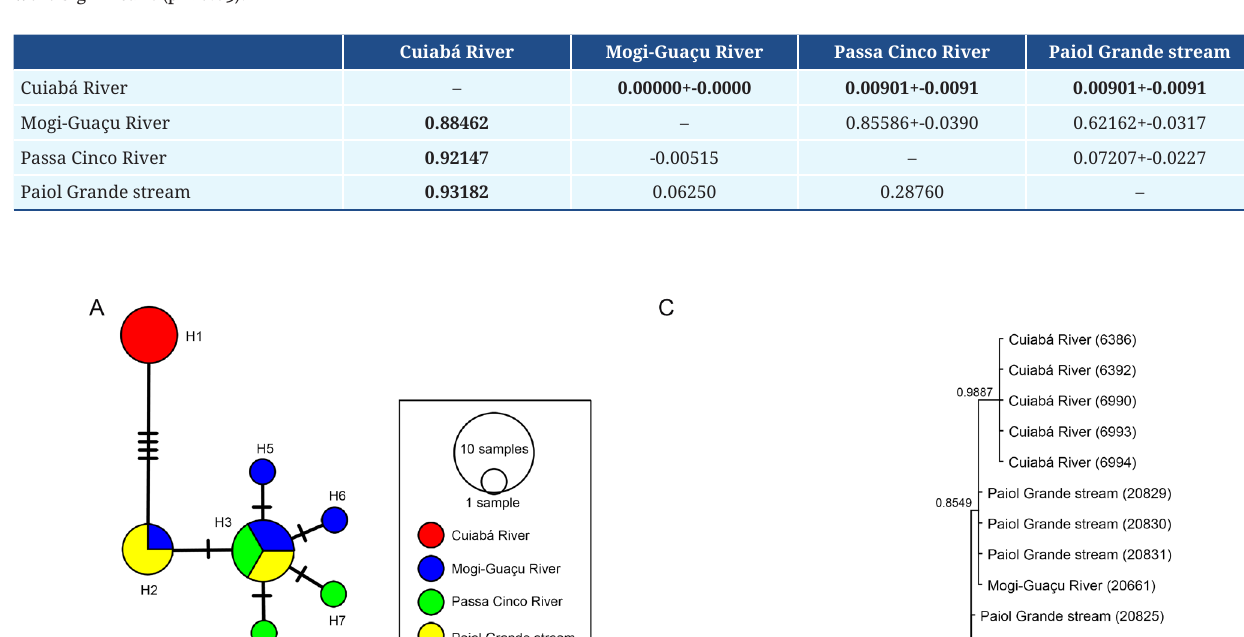
TABLE 4 | Population pairwise FSTs values for the populations of Parodon nasus (lower diagonal) and p-values (upper diagonal). Bold values were significant (p < 0.05).